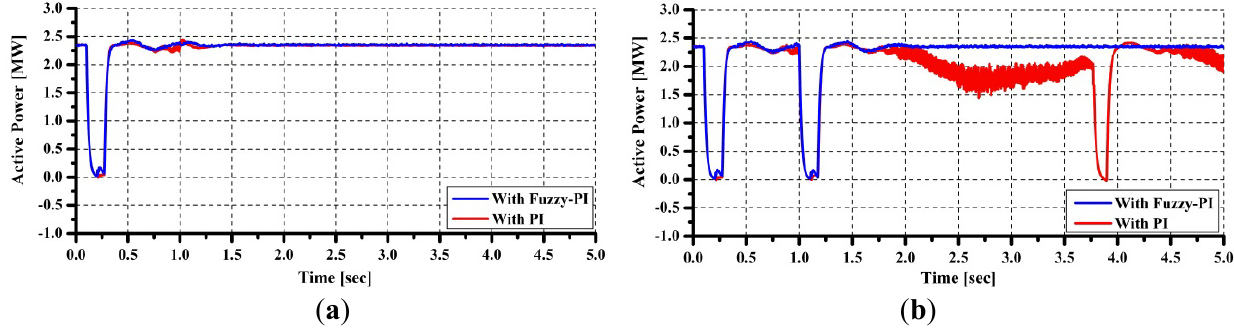
Figure 25. Active power output of PMSG. ( a ) case 1; ( b ) Case 2.